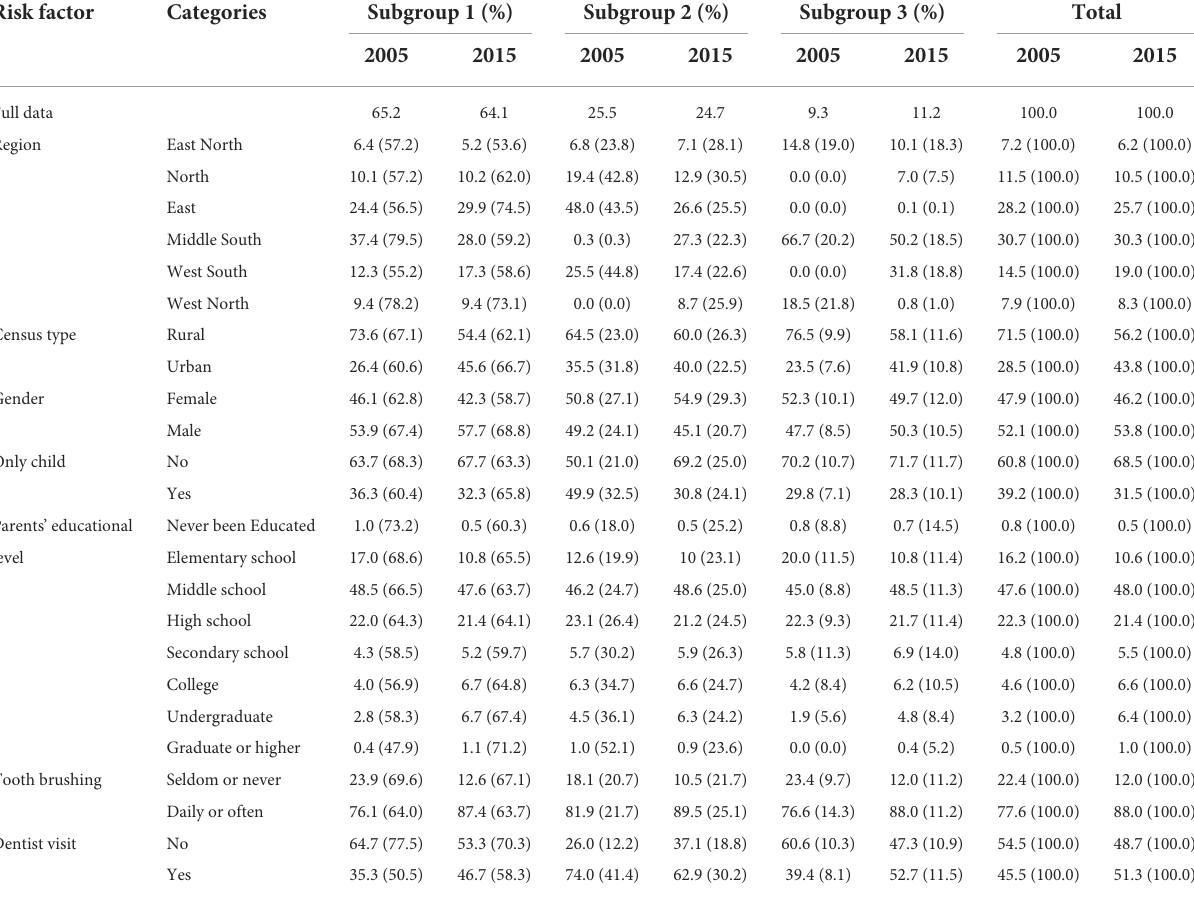
TABLE 2 Population proportions for risk factor-based